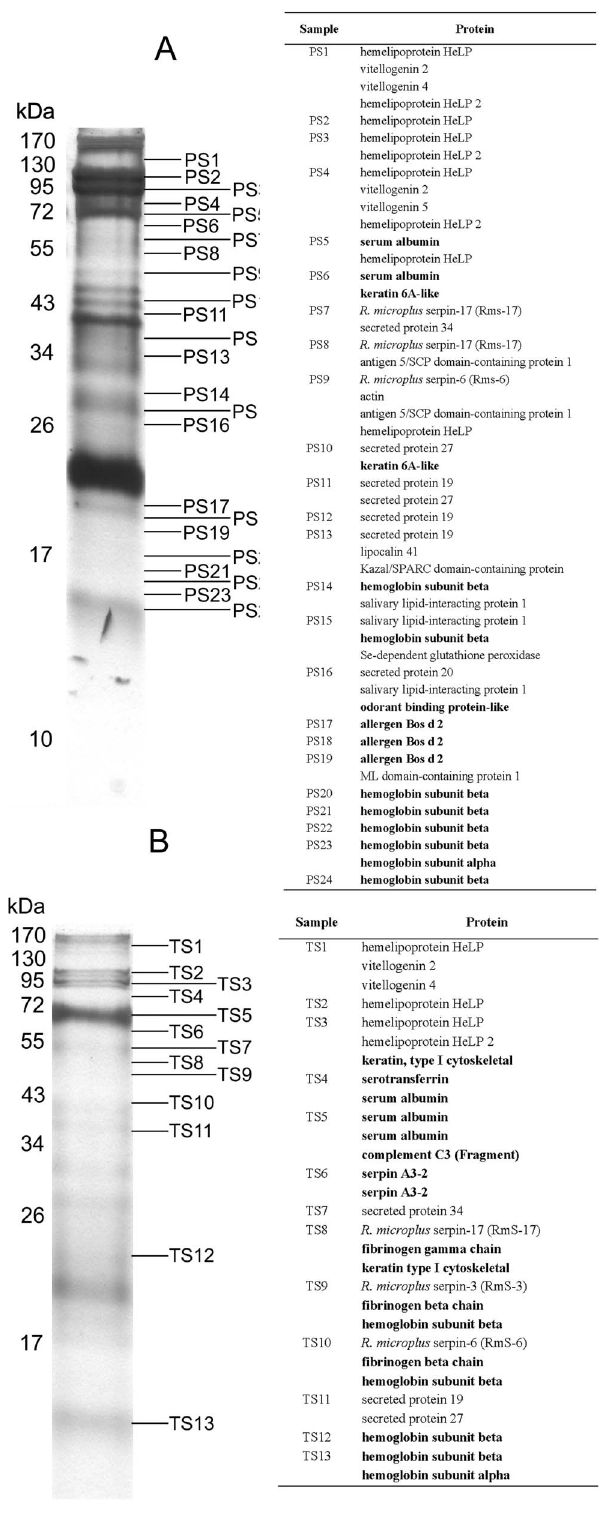
Figure 1. Proteome of R. microplus saliva. Saliva (25 m g) from partially engorged females (PEF) (A) and fully engorged females ticks (FEF) (B) was electrophoresed in 12% SDS-PAGE. The bands were excised, submitted for tryptic digestion and identified by LC–MS/MS. Numbers at the left indicate the MW in kDa of the protein standards. Host proteins identified are presented in bold. For further description of protein identification see Table S1 and Table S2. doi:10.1371/journal.pone.0094831.g001 PLOS ONE |